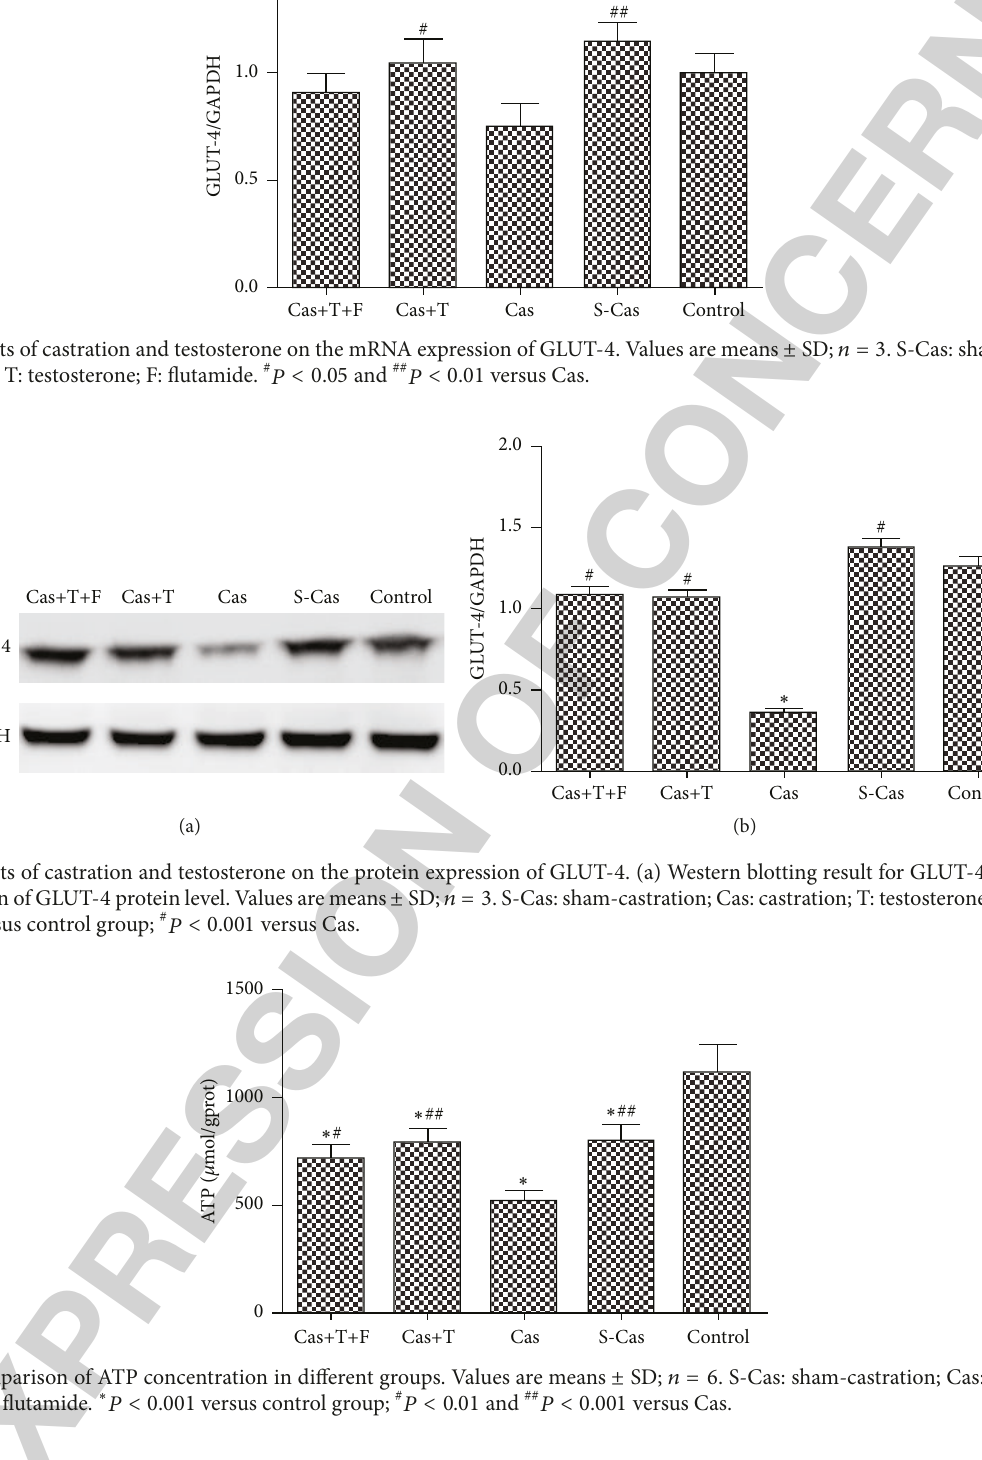
(514.96 ± 56.96 versus 794.80 ± 82.97 𝜇 mol/gprot, 𝑃 < 0.001 ). With the treatment of testosterone, the levels of ATP